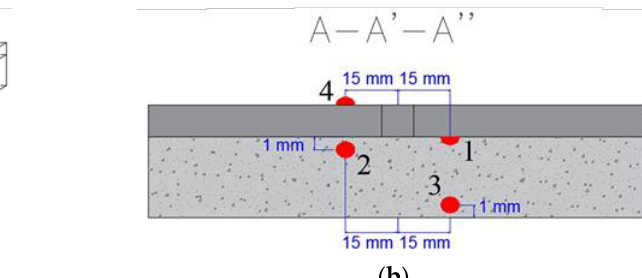
spective dimensions.